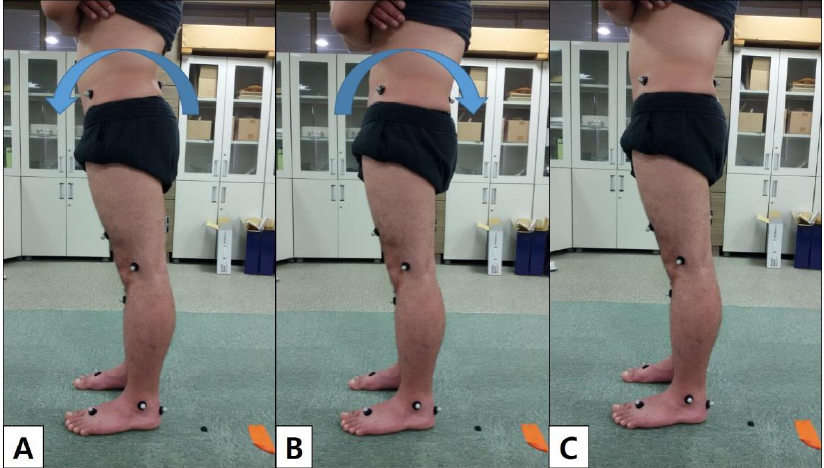
Figure 2. Illustration showing the double-leg support with pelvis anterior ( A ), posterior tilt posture ( B ), and resting posture ( C ) in lateral view.